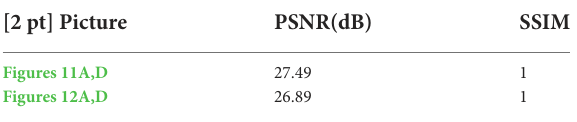
TABLE 5 Reconstruction quality analysis. TABLE 6 NIST test.